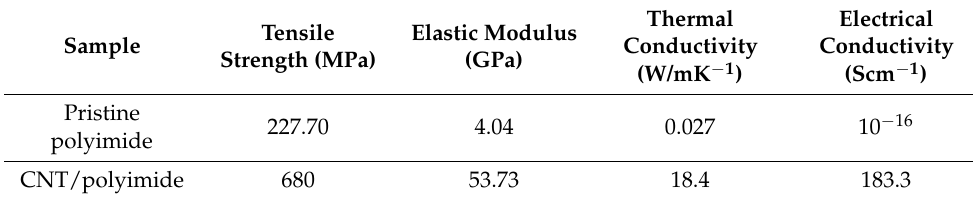
Table 4. Mechanical, electrical, and thermal properties of pure polyimide and a CNT/polyimide